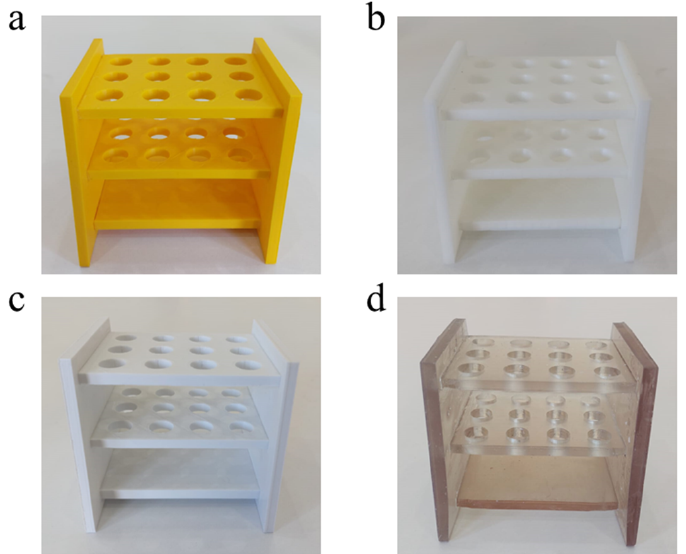
Figure 3. Plastic test tube rack fabricated by AM ( a ) Rack fabricated using ABS ( b ) Rack fabricated using PLA ( c ) Rack fabricated using PETG ( d ) Rack fabricated using UV Resin.